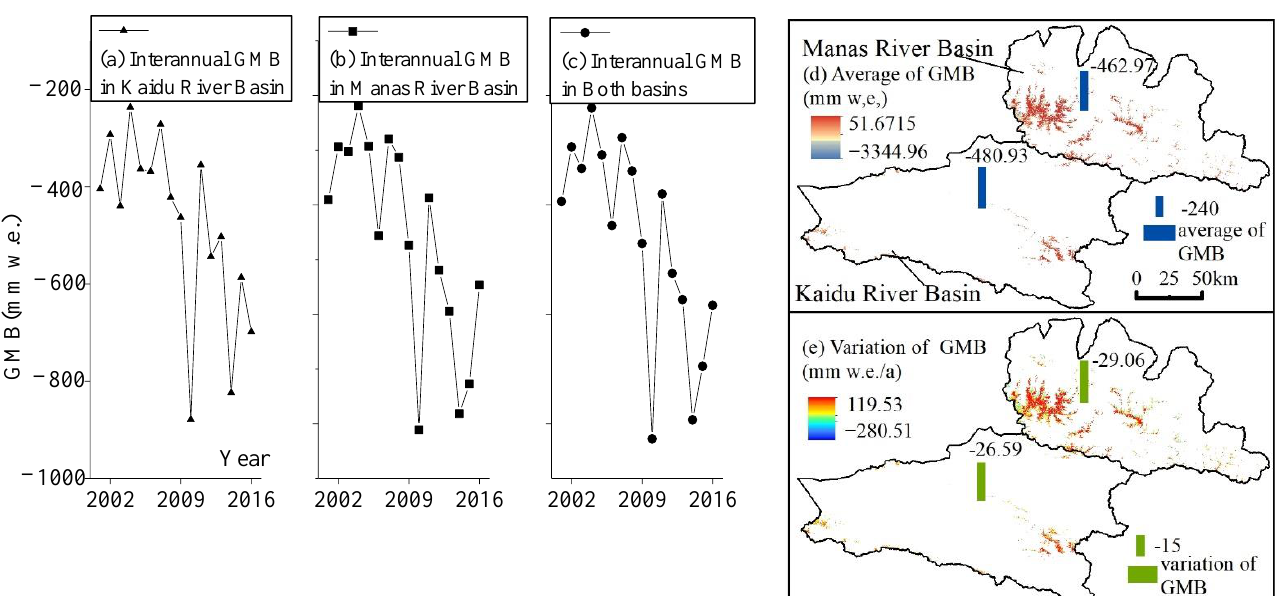
Figure 5. Glacier mass balance in both basins in central Tianshan (2001–2016). ( a ) Interannual GMB in Kaidu River Basin; ( b ) Interannual GMB in Manas River Basin; ( c ) Interannual GMB in Both Basin; ( d ) Average of GMB; ( e ) Variation of GMB.